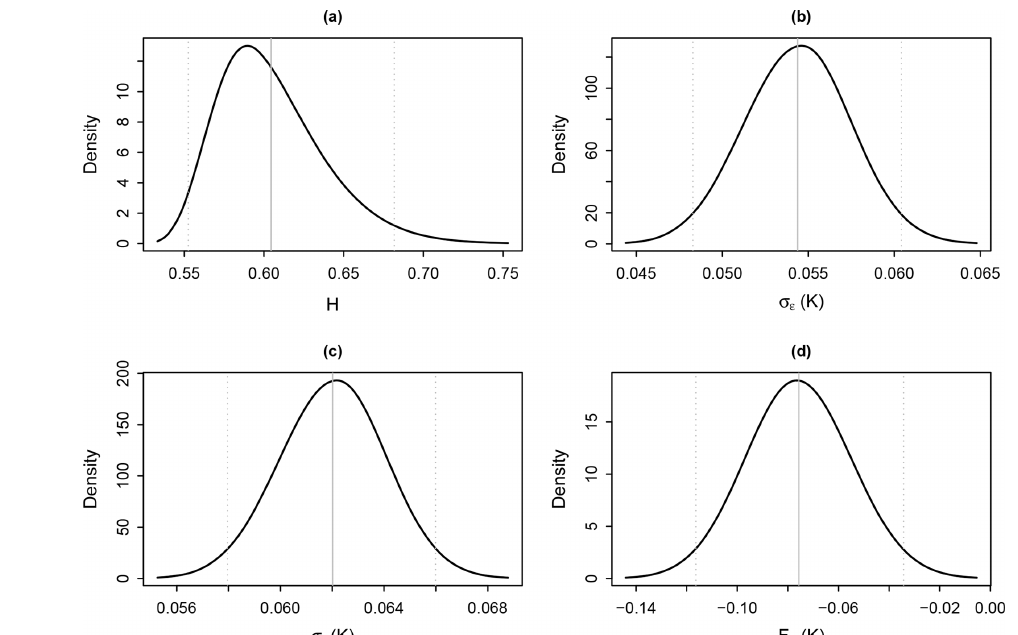
Figure 1. The marginal posterior distributions of the parameters obtained using INLA.climate to fit our model to the GISS-E2-R tem- perature and forcing dataset. The vertical lines show the mean and 95% credible intervals.